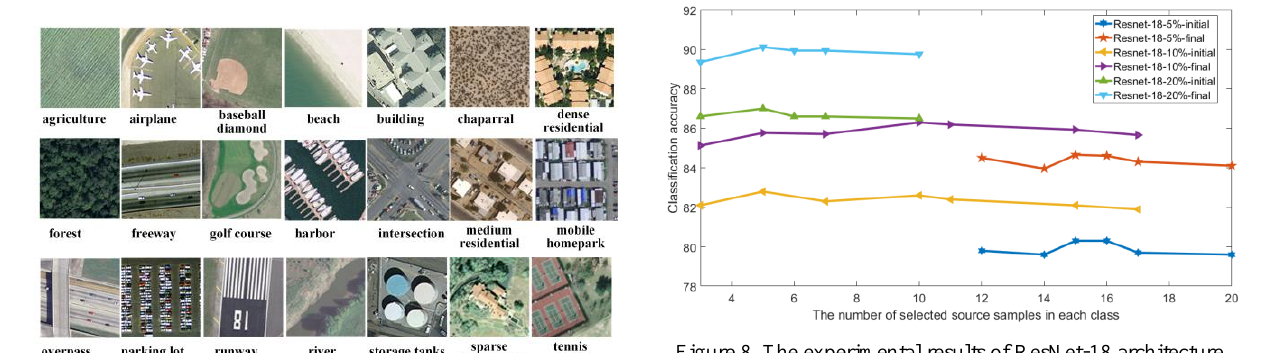
Figure 8. The experimental results of ResNet-18 architecture with diverse chosen source sample number.